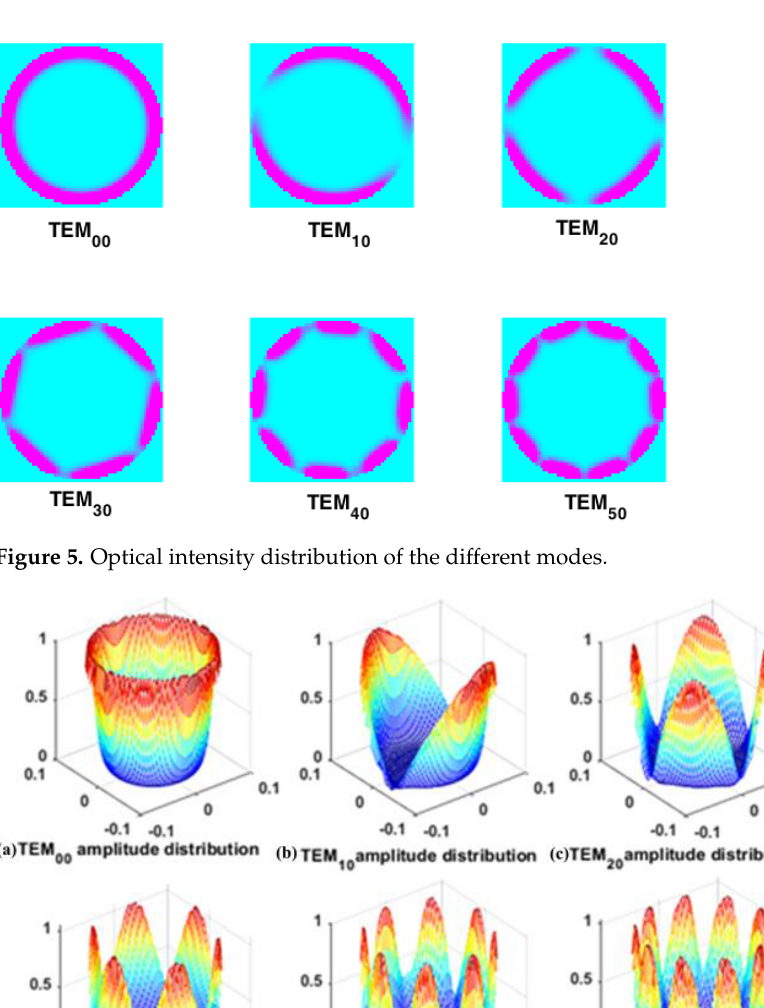
Figure 5. Optical intensity distribution of the different modes.